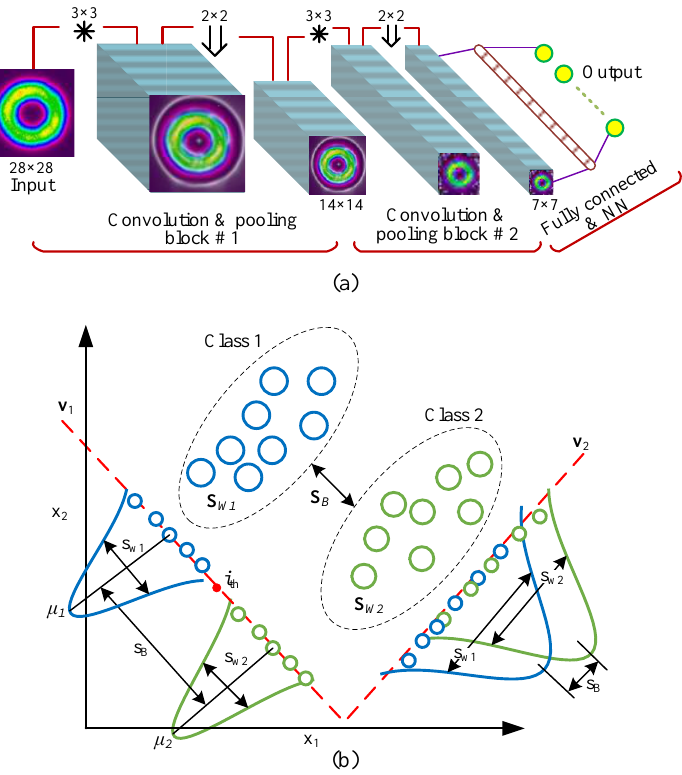
Figure 5. ( a ) CNN-based classifier architecture. ( b ) LDA-based classifer